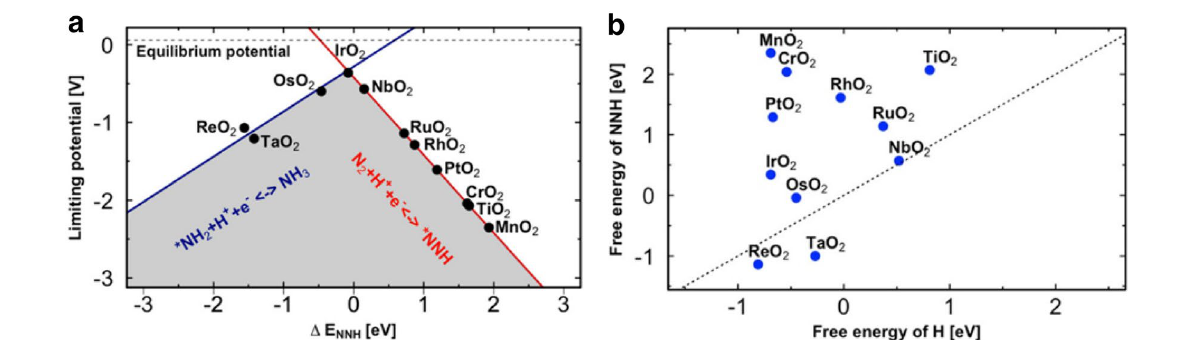
Fig. 2 a Potential determining steps for the electrochemical N 2 fixation to NH 3 on metal oxide surfaces with binding energies of NNH. b Comparison of the free energy adsorption of NNH and that of H on metal oxide surfaces. (The dashed lines indicate where these free energies are equal. The oxides below these dashed lines show that NH 3 formation can occur without being poisoned with protons) (Reproduced with permission [30] Copyright 2017, American Chemical Society